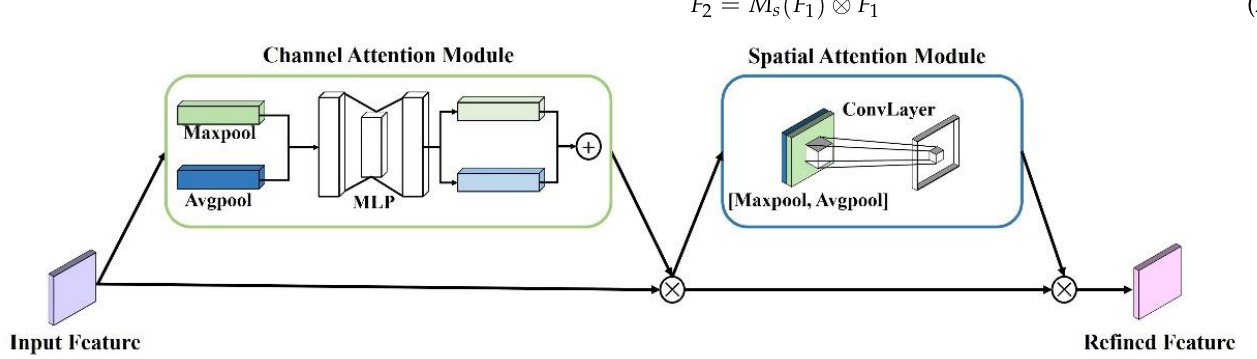
Figure 1. Structure of the convolutional block attention module (CBAM). MLP, multilayer percep- tron.